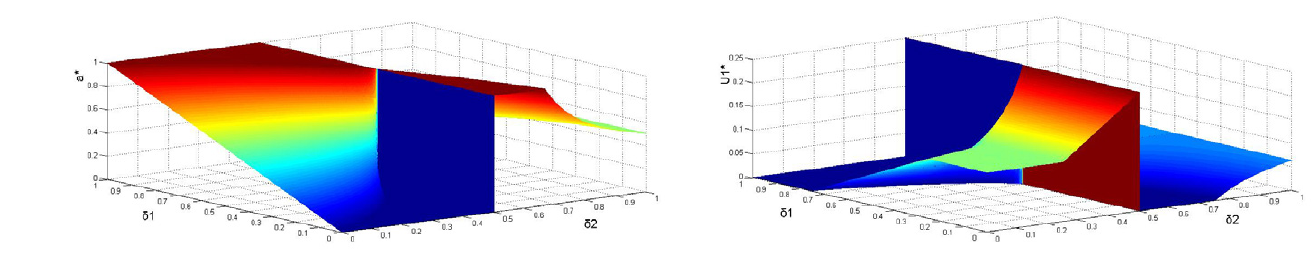
Figure 4. T he relationship between * a and δ 1 , δ 2 Figure 5. T he relationship between (Figure 4). To identify effective incentives, blindly improv-